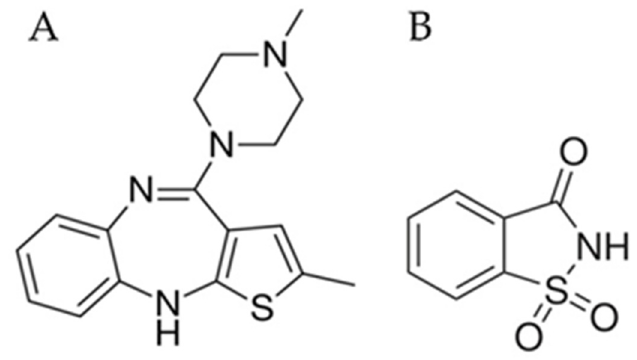
Figure 1. Chemical structure of olanzapine ( A ) and saccharin ( B ).